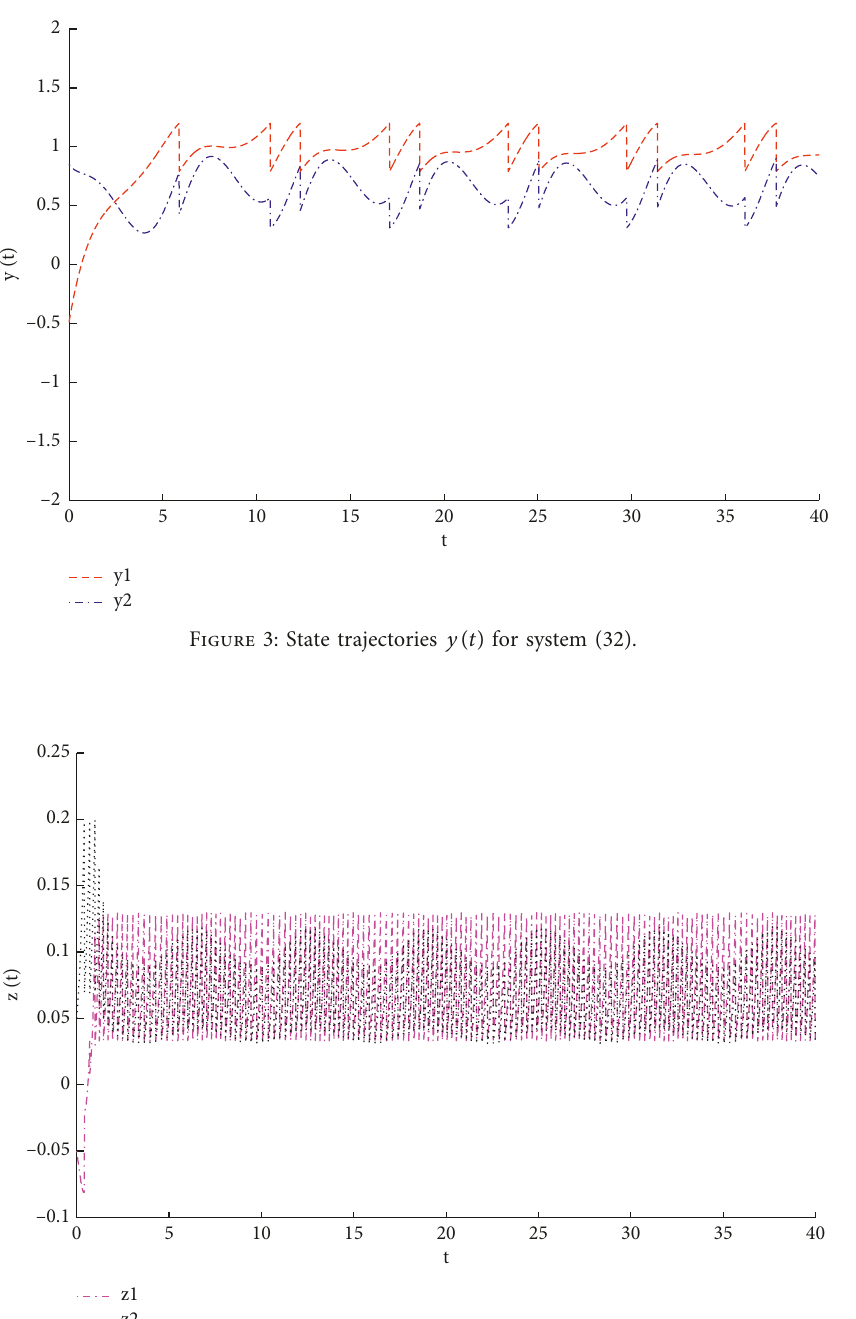
Figure 4: State trajectories z ( t ) for system (4) without